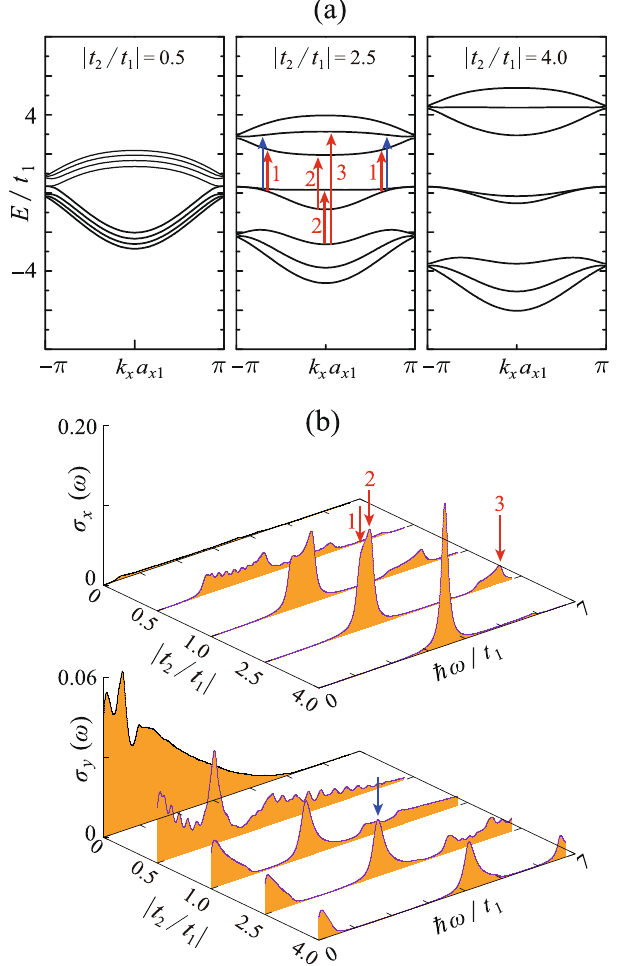
Figure 4. ( a ) Dispersion relations of 4z-Q1D-PNR with varying | t 2 / t 1 |; ( b ) the x -polarized optical conductivity spectra σ x and the y -polarized ones σ y as functions of | t 2 / t 1 |. The interband transitions contributing to the absorptions peaks are pointed out by the red (for x -polarization) and blue (for y -polarization)